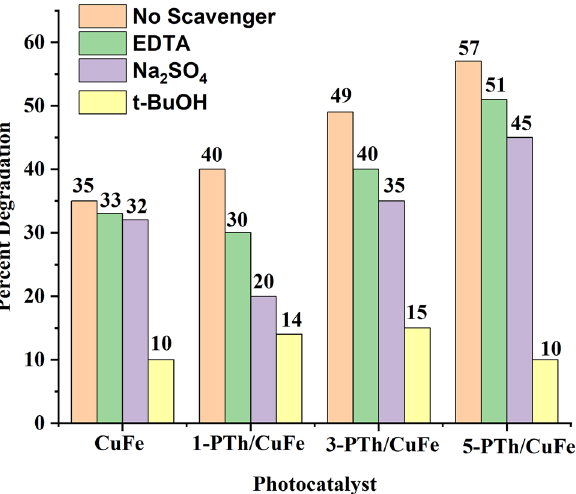
Figure 4. Effect of addition of radical scavenger on CuFe 2 O 4 , PTh/CuFe 2 O 4 nanohybrids.